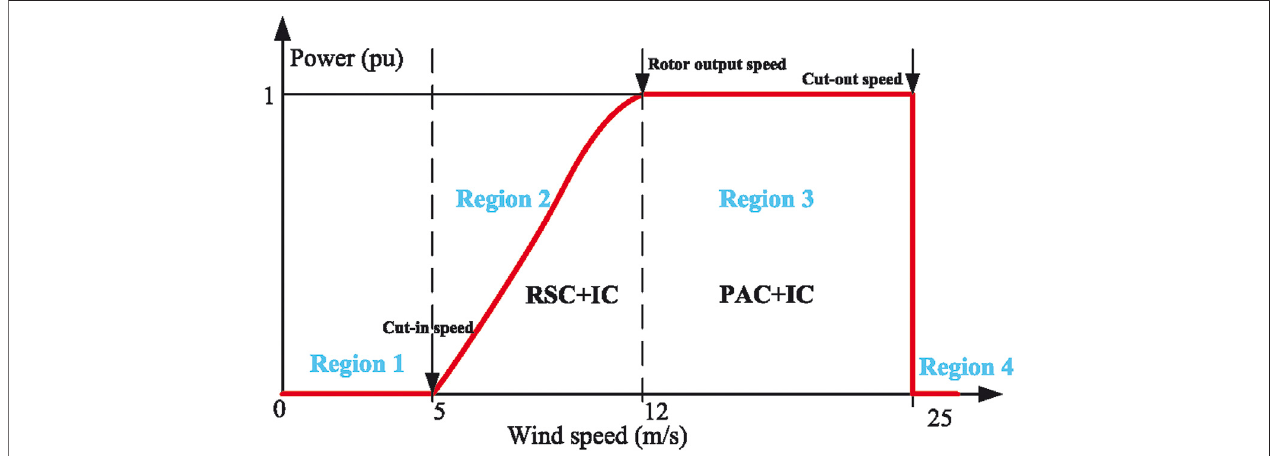
FIGURE 2 | The wind turbine power output curve with different wind